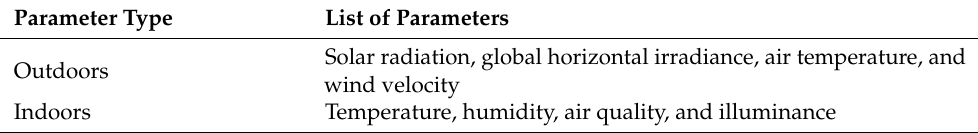
Table 4. Weather control